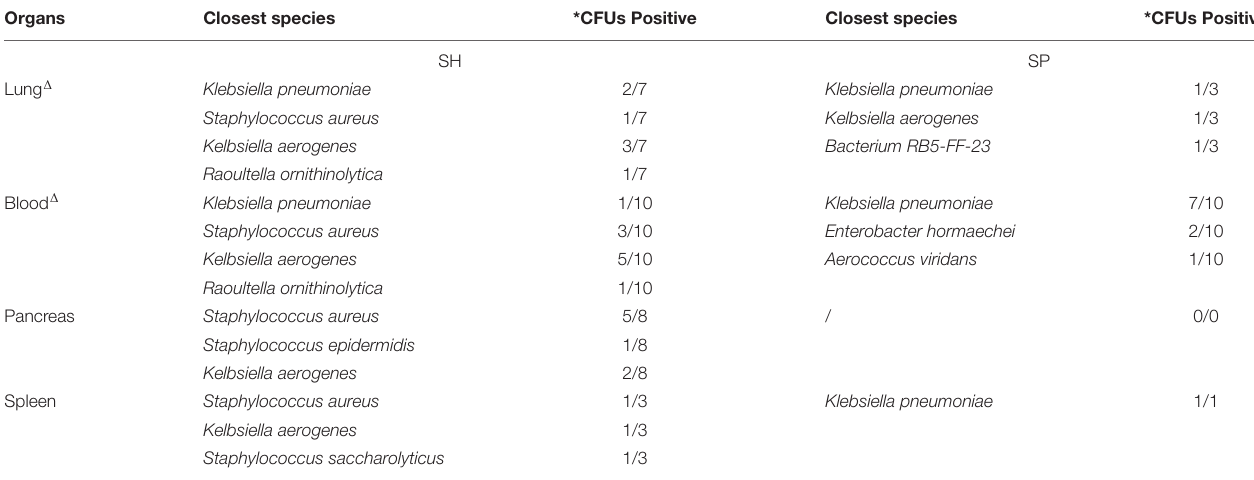
TABLE 1 | Identification of bacteria translocating into the extra-oral sites between SH and SP. Organs Closest species *CFUs Positive Closest species *CFUs Positive SH